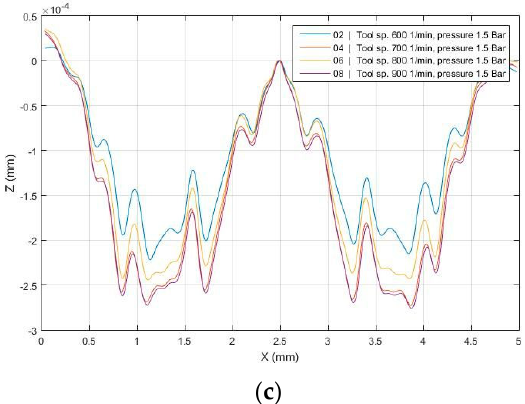
Figure 3. FEM R1O tool at 0 bar ( a ), 0.7 bar ( b ), and 1.5 bar ( c ).